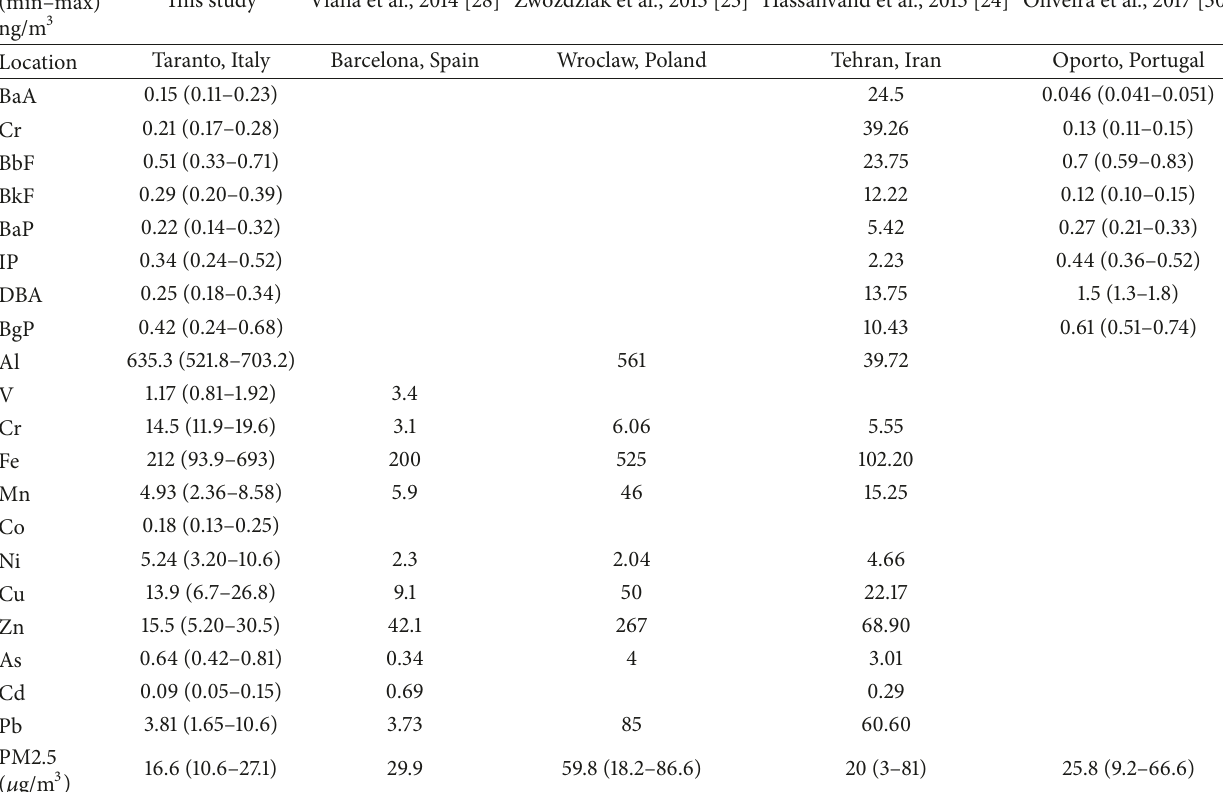
Table 1: Mean, minimum, and maximum concentration of PM2.5 ( 𝜇 g/m 3 ), PAHs, and metals (ng/m 3 ) measured inside the investigated